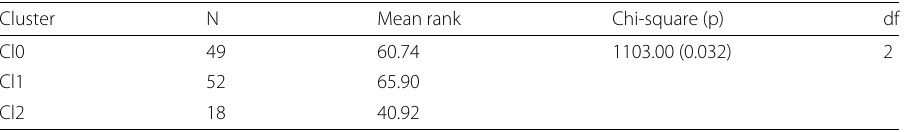
Table 4 Performance averages and Kruskal-Wallis test results in each cluster (N is the number of students in the given cluster Cluster N Mean rank Chi-square (p) df Cl0 49 60.74 1103.00 (0.032) 2 Cl1 52 65.90 Cl2 18 40.92